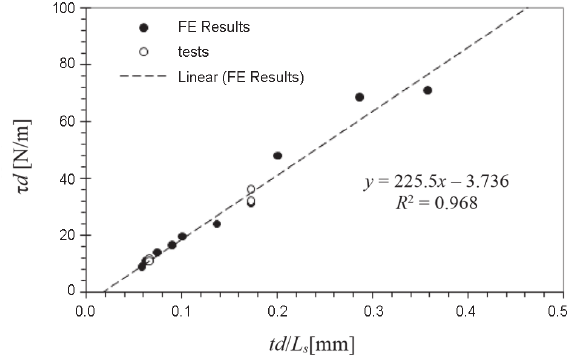
Fig. 10. τd versus td/L s for combined results for slabs on 51 mm deck with various sheeting thicknesses (FE models #28 – #38 of Table 2 and test data of specimens #10 – #15 of Table 1)